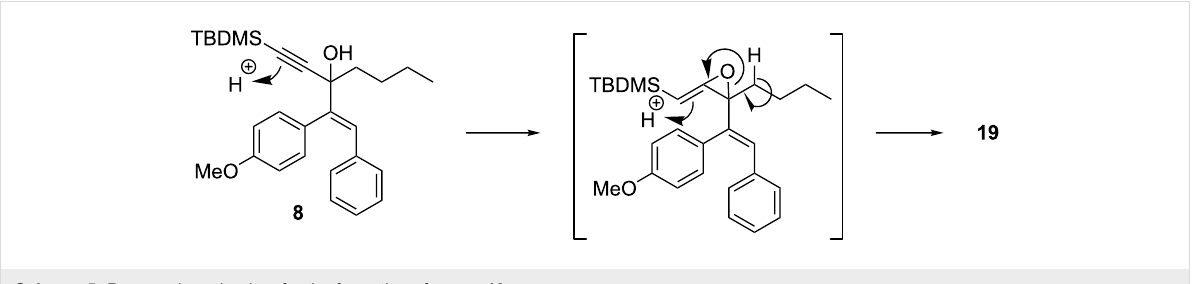
Scheme 5: Proposed mechanism for the formation of enone 19 .